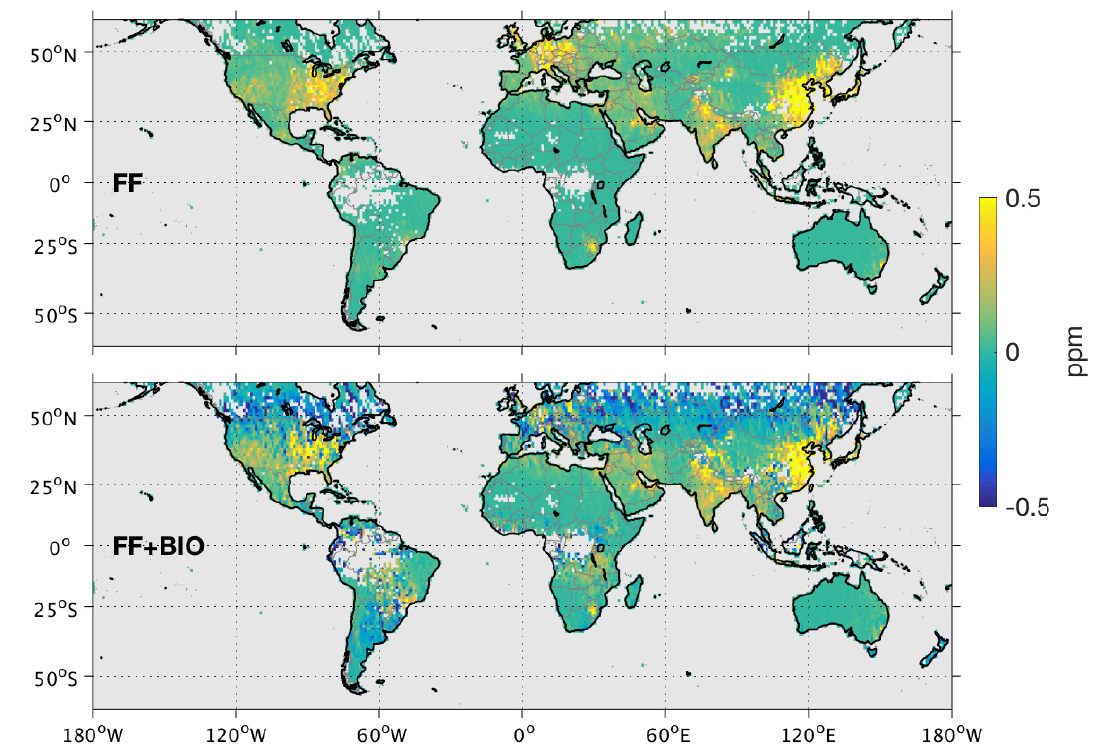
Figure 7. FLEXPART simulation results for the year 2015 with contribution from fossil fuel combustion (FF) only and also with biospheric component (FF +